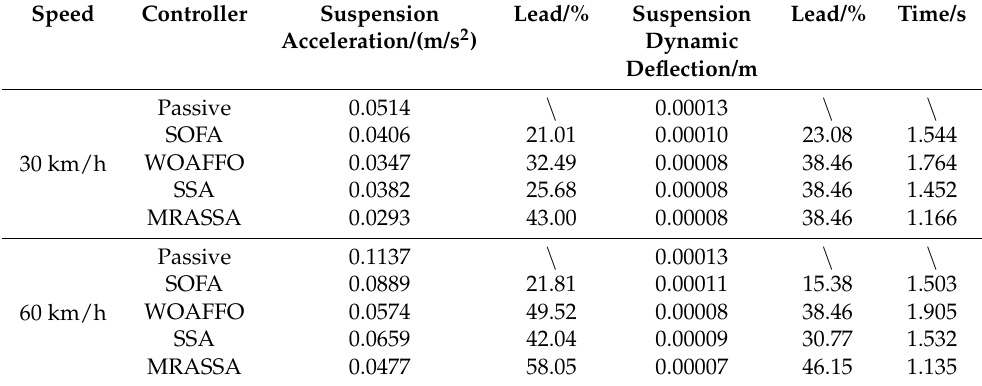
Table 5. Optimization Results for Platform of the Single Bump. Speed